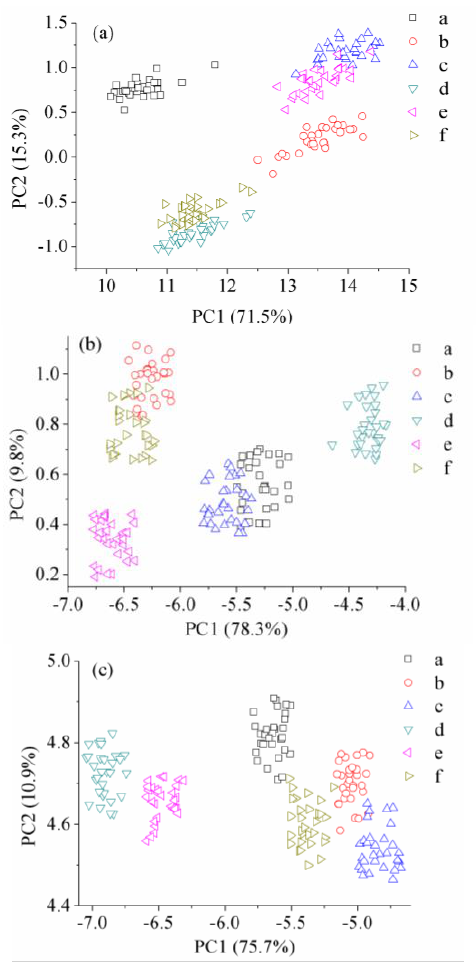
Figure 3. The principle component analysis scores of eight vegetation species under different excitation wavelengths: (a) 355 nm; (b) 460 nm; (c) 556